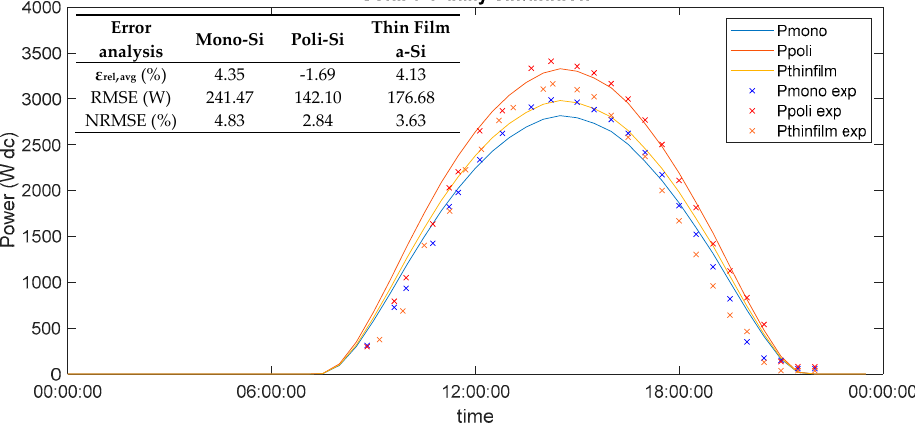
Figure 4. Validation of the solar PV model for the three technologies and error analysis.